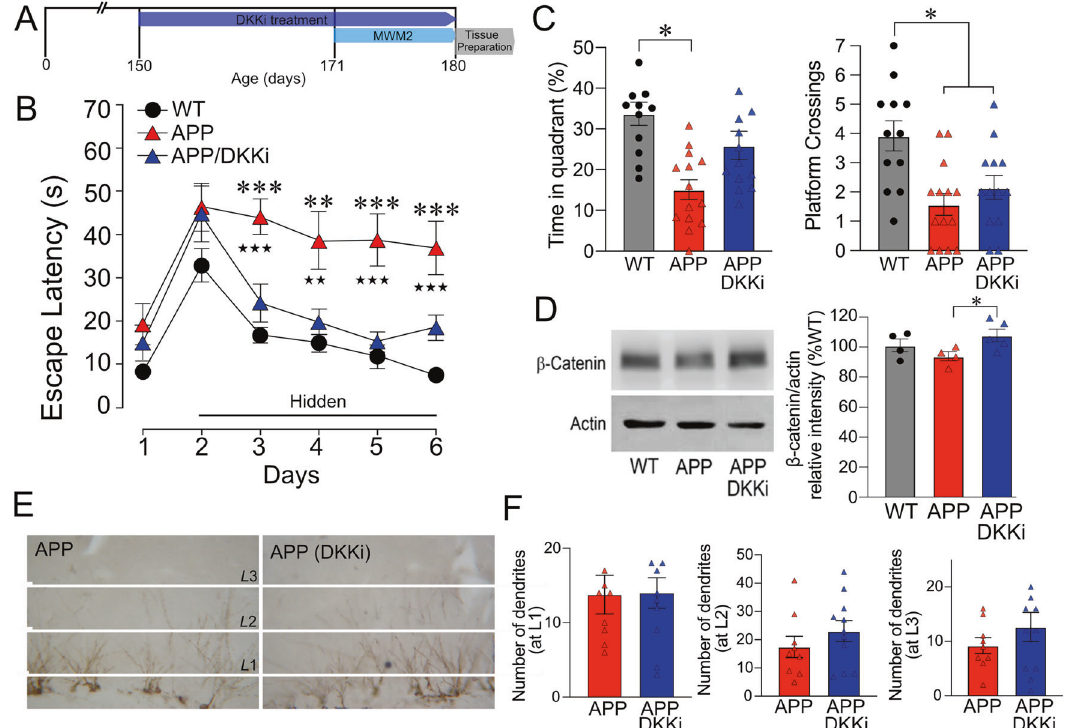
Fig. 5 DKK1 inhibitor improved spatial learning and memory and hippocampal β -catenin protein levels in APP mice. A Schematic representation of experimental design and timeline of DKK1 inhibitor (DKKi) treatment. B One month of icv administration of the DKKi WAY- 262611 restored spatial learning during all days of hidden platform testing in treated APP mice (blue triangle) compared to untreated APP mice that were severely impaired (red triangle) in the Morris water maze (MWM2) compared to both WT and APP mice treated with the DKKi. C During the probe trial, APP mice demonstrated de fi cits compared to WT, as shown here by a shorter time spent in the target quadrant and less crossings over the previous location of the platform. DKKi-treated APP mice had restored memory as shown by the same time spent in the target quadrant as WT controls, but precision was not improved as crossings over the previous location of the platform were still impaired. D Representative Western blots of β -catenin expression in WT, APP and DKKi-treated APP mice. Although hippocampal β -catenin protein levels were not signi fi cantly decreased in APP mice compared to WT, the DKKi WAY-262611 signi fi cantly increased them in treated APP mice. ( E ) DCX-immunostained dendritic extensions were counted in three segments (L1, L2, and L3) of the DG molecular layer in APP and DKKi-treated APP mice. Although more extensions were present in L2 and L3, it did not reach signi fi cance ( F ). *APP compared to WT ( B ); DKKi-treated APP compared to APP ( B ). * p < 0.05; ** p < 0.01; *** p < 0.001 using one-way ANOVA and repeated measures ANOVA followed by Newman – Keuls post-hoc